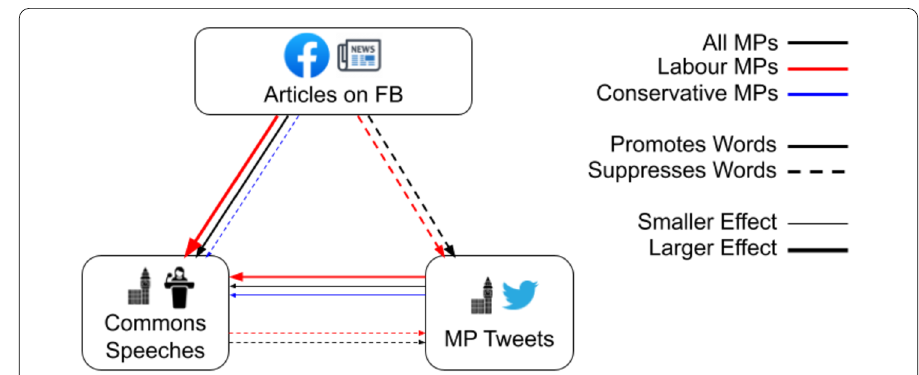
Figure 6 Overall word transfer between domains, by party. Lines indicate statistically significant measurements. Colors indicate the party of the MPs for whom we’re measuring a response. Note that lines from Commons to Articles and lines from Tweets to Articles are omitted because Articles do not have clear party affiliations, and so these values are undefined. Line thickness is proportional to the log of the measured effect. See Table 1 for precise magnitudes, p -values, and 95% confidence intervals